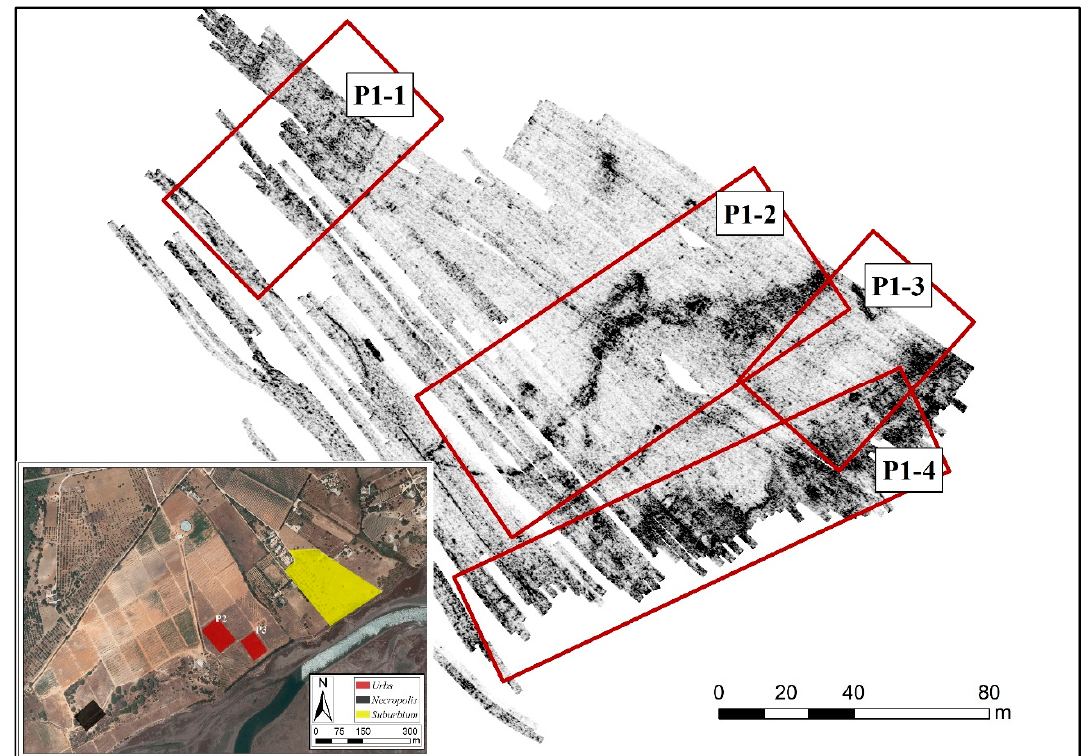
Figure 11. Groups of alterations in project 1.